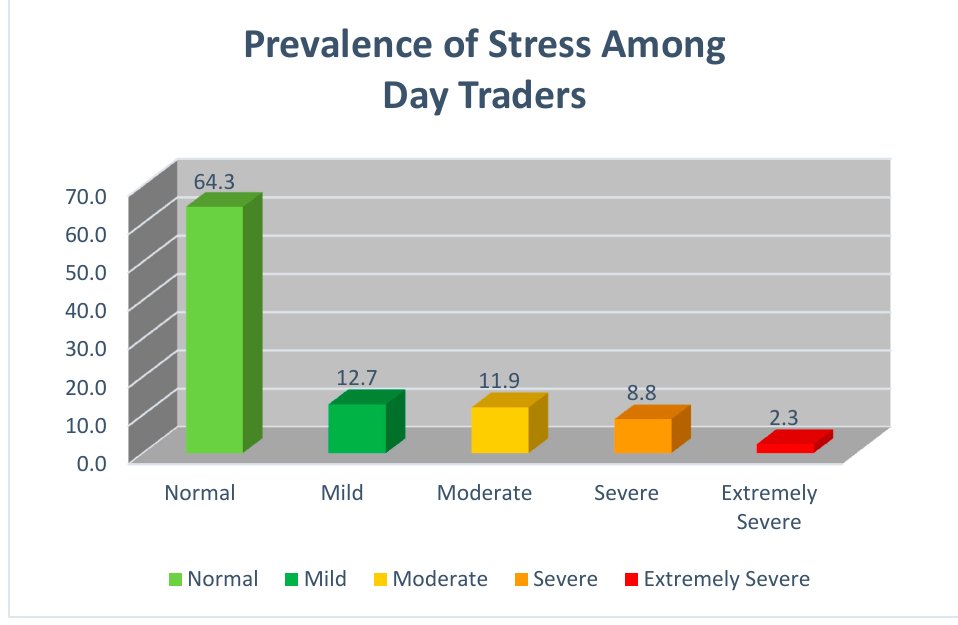
Figure 1. Prevalence of Stress Among Day Traders. Day traders were classified (displayed in Figure 2) as normal anxiety (N = 220, 56.8%), as mild anxiety (N = 23, 5.9%), as moderate anxiety (N = 72, 18.6%), as severe (N = 23, 5.9%), and as extremely severe (N = 49, 12.7%). See Figure 2.